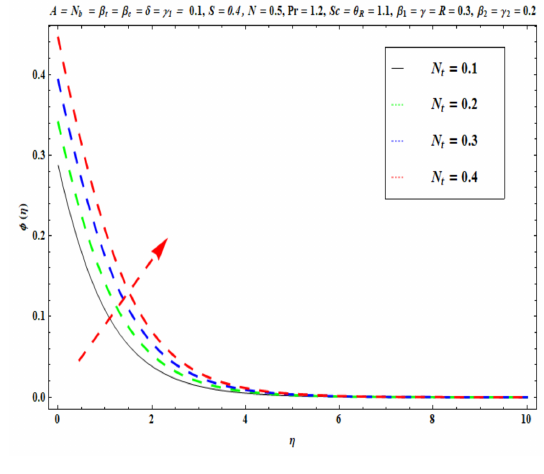
Figure 16. Against N t .